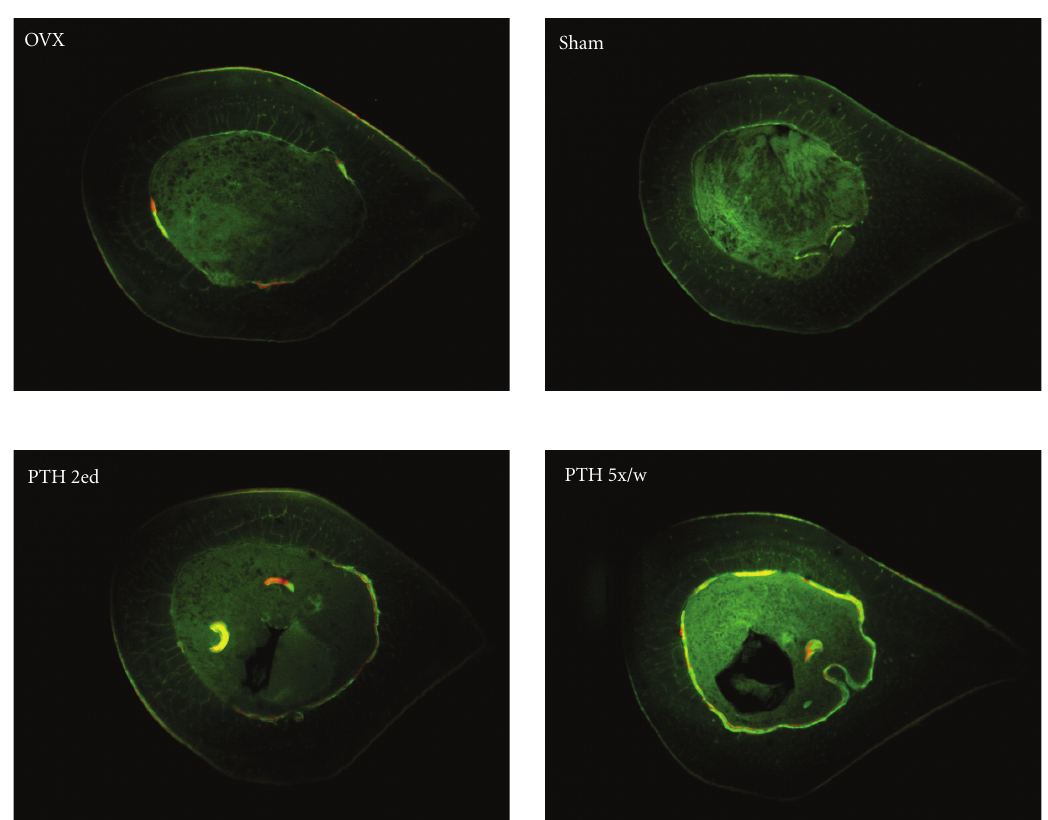
Figure 3: Analysis of fluorescence apposition bands in transversal sections from the subtrochanteric region of rat femur. The sections (all sections 15 mm distal from femoral head) were studied by fluorescence microscopy. In the OVX group, we could mainly observe a periosteal activity. In the sham group, only a minimal periosteal bone formation could be seen. The PTH e2d-treated animals showed weaker endosteal appositions in comparison to the PTH 5x/w